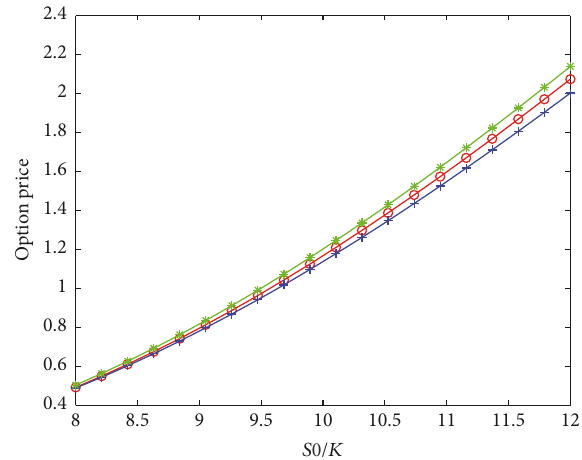
Figure 6: Vulnerable European call option price against spot-to- strike ratio for three cases with parameters 𝜇 1 = 0.01, 𝜇 2 = 0.09, 𝜎 = 0.1, 𝜎 = 0.3 1 2